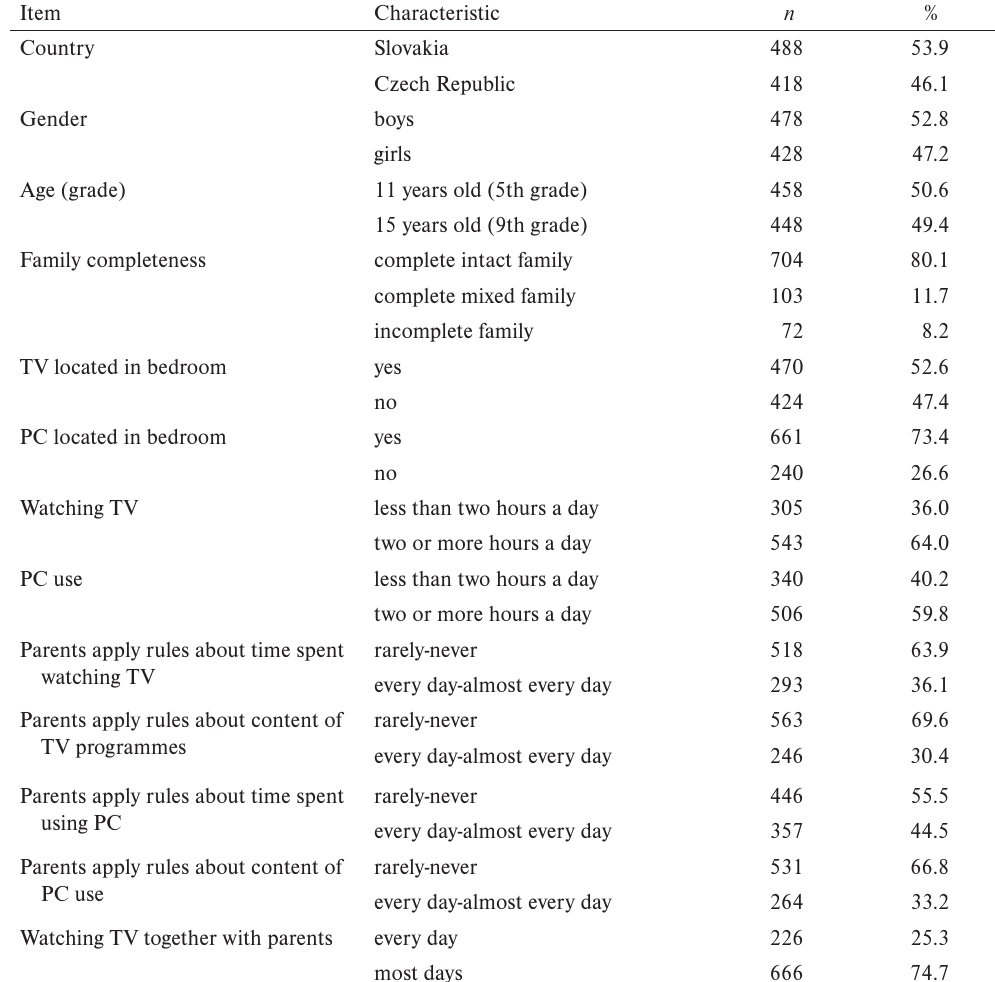
Descriptive characteristics of the